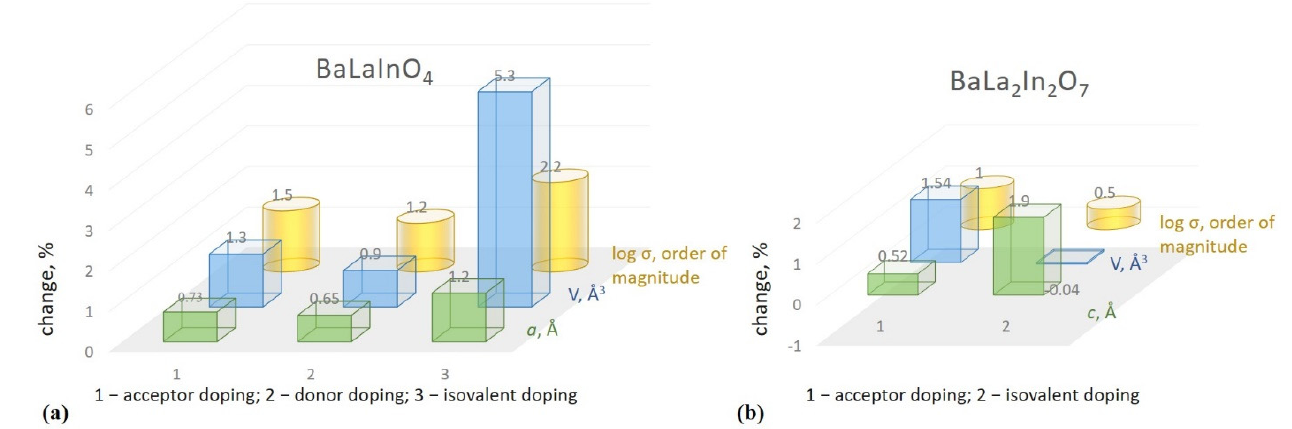
Figure 5. The changes in the lattice parameters, unit cell volumes and oxygen-ionic conductivity values for doped compositions based on monolayer BaLaInO 4 ( a ) and two-layer BaLa 2 In 2 O 7 perovskites ( b ).